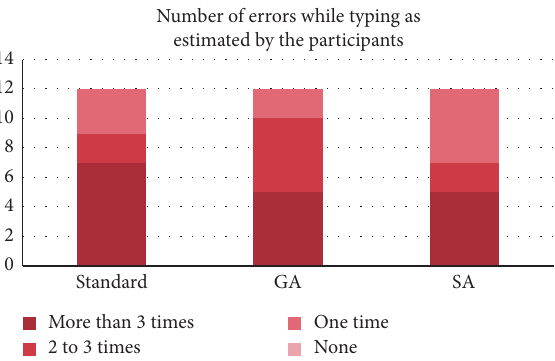
Figure 11: The error rates as evaluated by the participants.